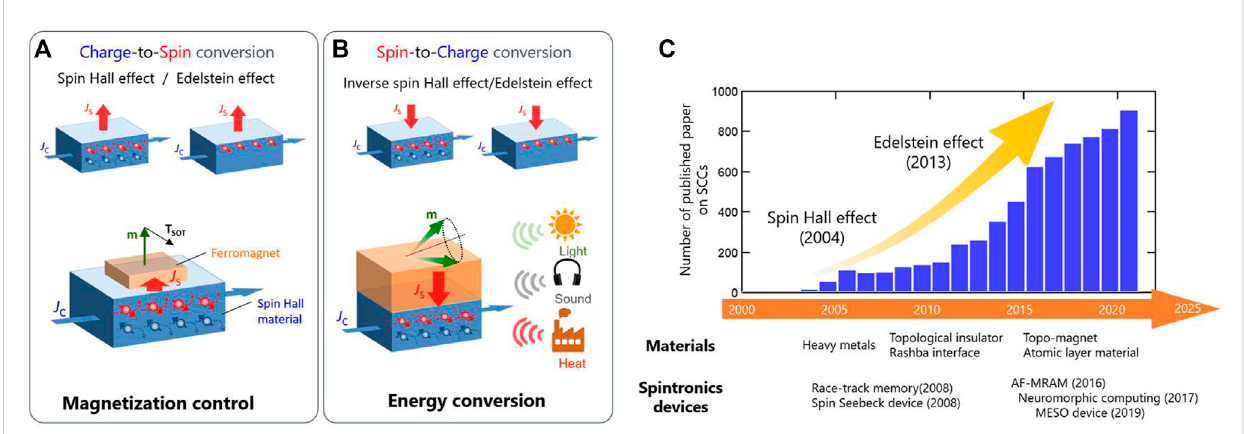
FIGURE 1 Spin – charge interconversion and its applications. (A) Charge-to-spin conversion due to spin Hall and Edelstein effects. In both cases, spins accumulate at the interface by applying the charge current. The spin accumulation gives rise to the spin – orbit torques (SOTs) to the adjacent ferromagnet. It is the working principle for SCC-based spintronic devices, such as magnetic memory, spin-torque nano-oscillator, and spin-wave logic. (B) Spin-to-charge conversion due to inverse spin Hall and inverse Edelstein effects. The inverse effects convert light, sound, and heat-to-charge currents via spin currents. (C) The number of studies on SCCs and proposed spintronics devices as a function of year. Searches for keywords, such as spin – charge conversion, spin Hall effect (SHE), Edelstein effect, and spin – orbit torque, on the Web of Science database. After the fi rst experimental observationoftheSHEin2004andtheEdelsteineffectin2013,thenumberofSCCstudiesincreasedyearlysincefundamentalresearchofSCCsbeganto trigger novel spintronics device concepts and